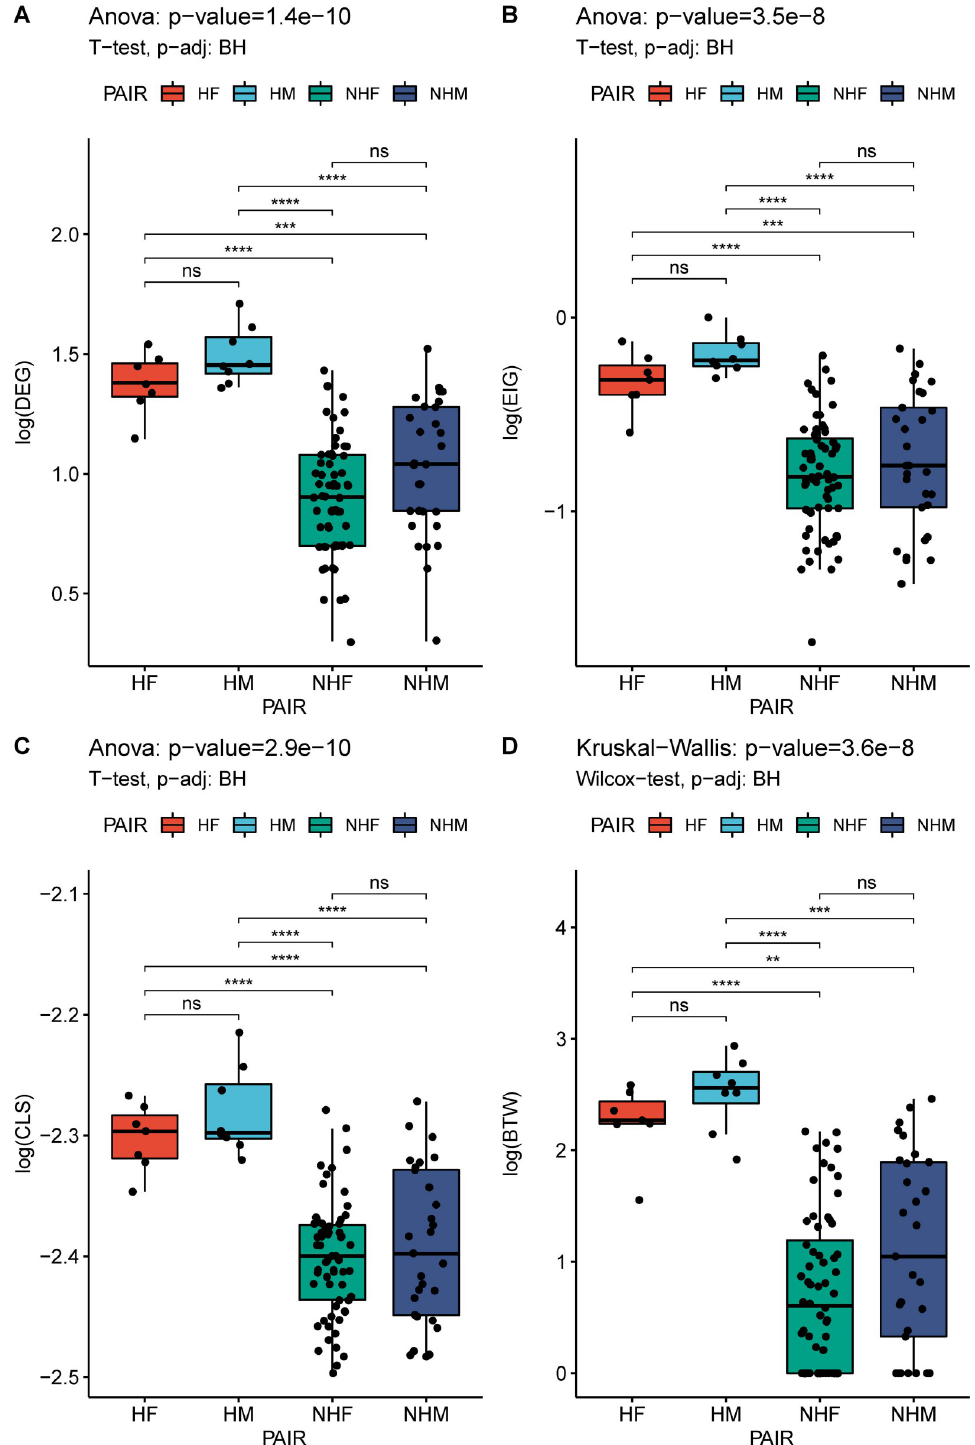
Fig 8. Post-hoc analysis for network centralities. A-C. Post-hoc test (pairwise t-test and ANOVA) for the centralities Degree (DEG), Closeness (CLS) and Eigenvector (EIG), the groups whose means were statistically different from one another. The groups were (1) female heads (HF) to female non-heads (NHF), male heads (HM) and male non-heads (NHM). D. Post-hoc results for the betweenness (BTW) centrality which was tested with a non-parametric alternative method (pairwise Wilcoxon test and Kruskal-Wallis test). The significance of the p-value in each test in indicated with the following symbols: < 0.0001 ‘ ���� ’, < 0.001 ‘ ��� ’, < 0.01 ‘ �� ’, < 0.05 ‘ � ’, < 1 ‘ns’.